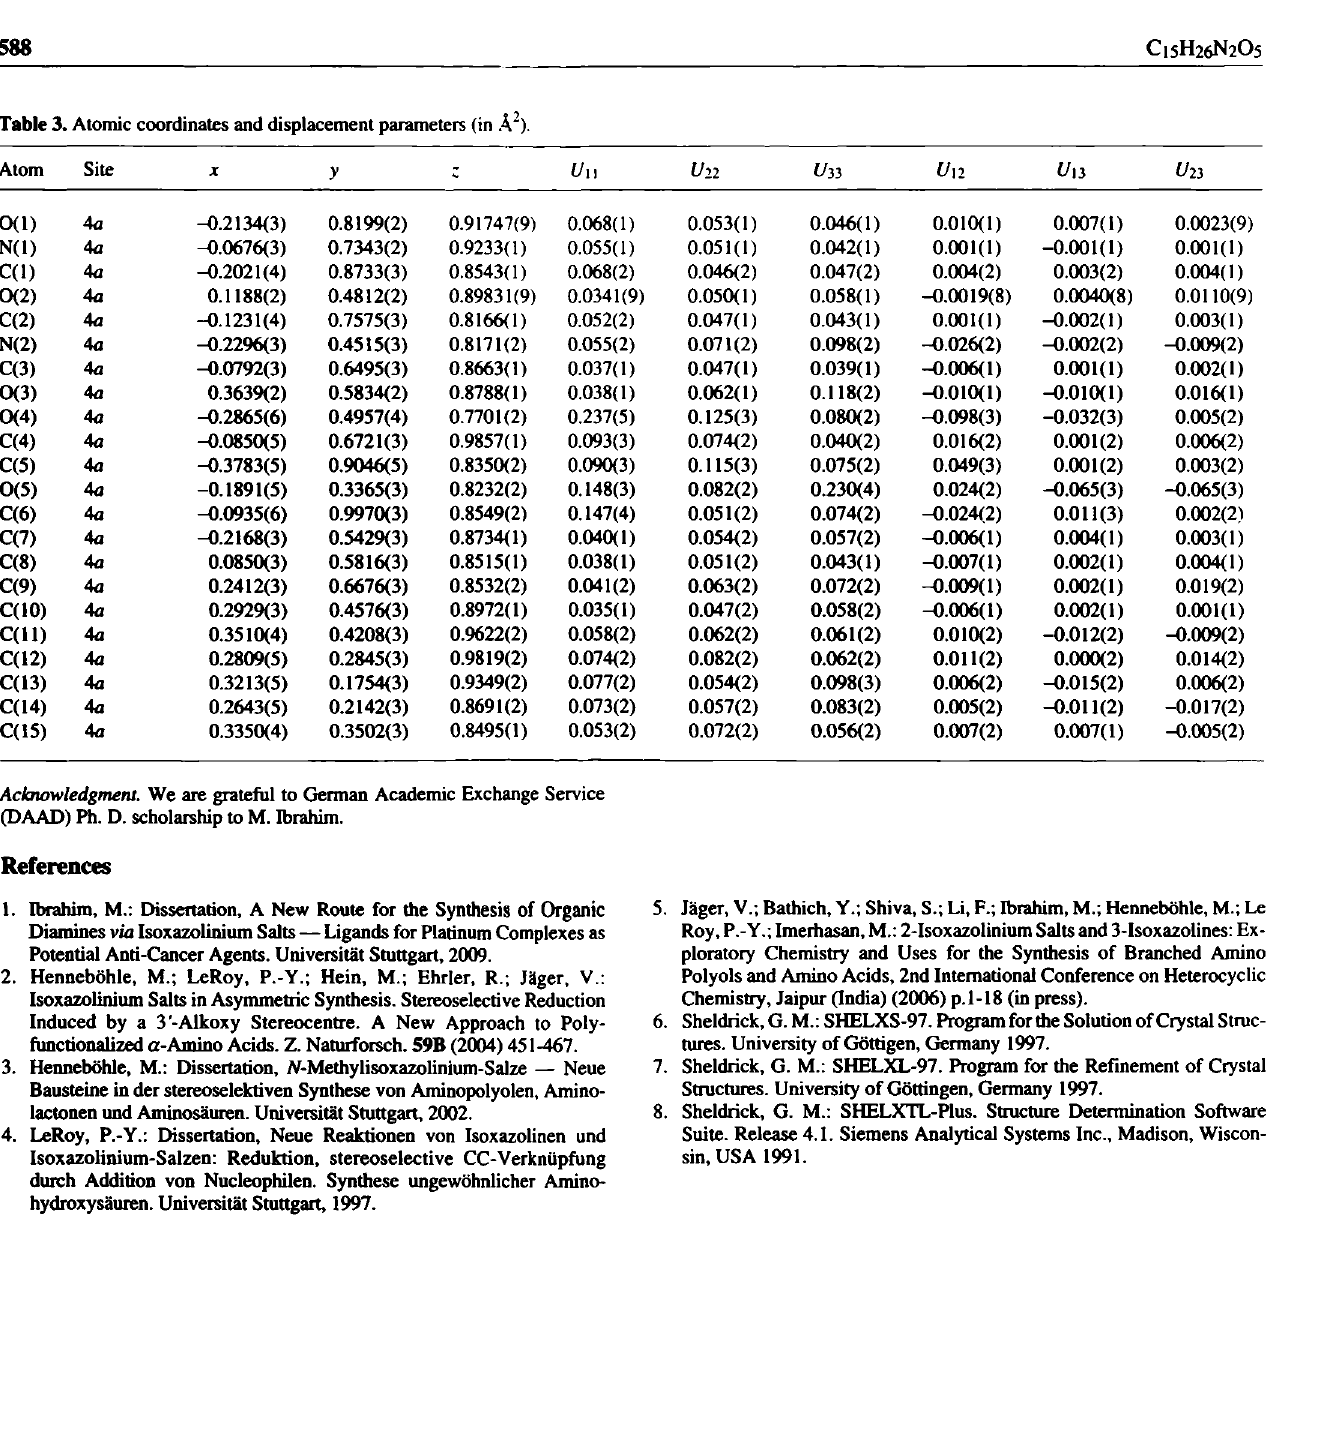
Table 3. Atomic coordinates and displacement parameters (in Â 2